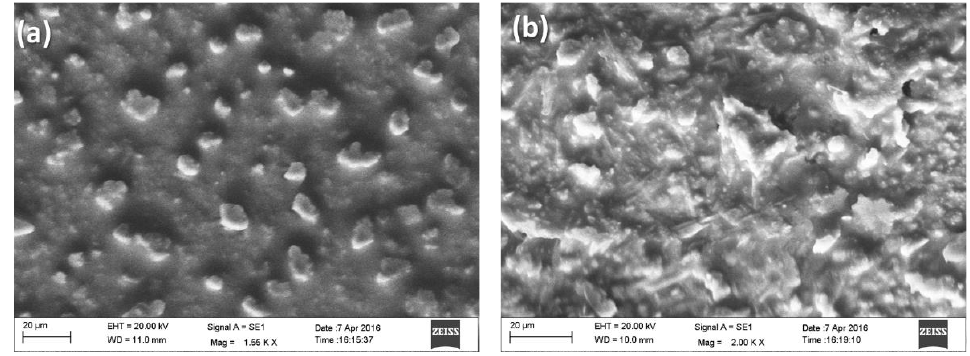
Figure 4. SEM images of ( a ) APTES/Gd 2 O 3 /ITO; ( b ) anti-CT/APTES/Gd 2 O 3 /ITO electrodes.